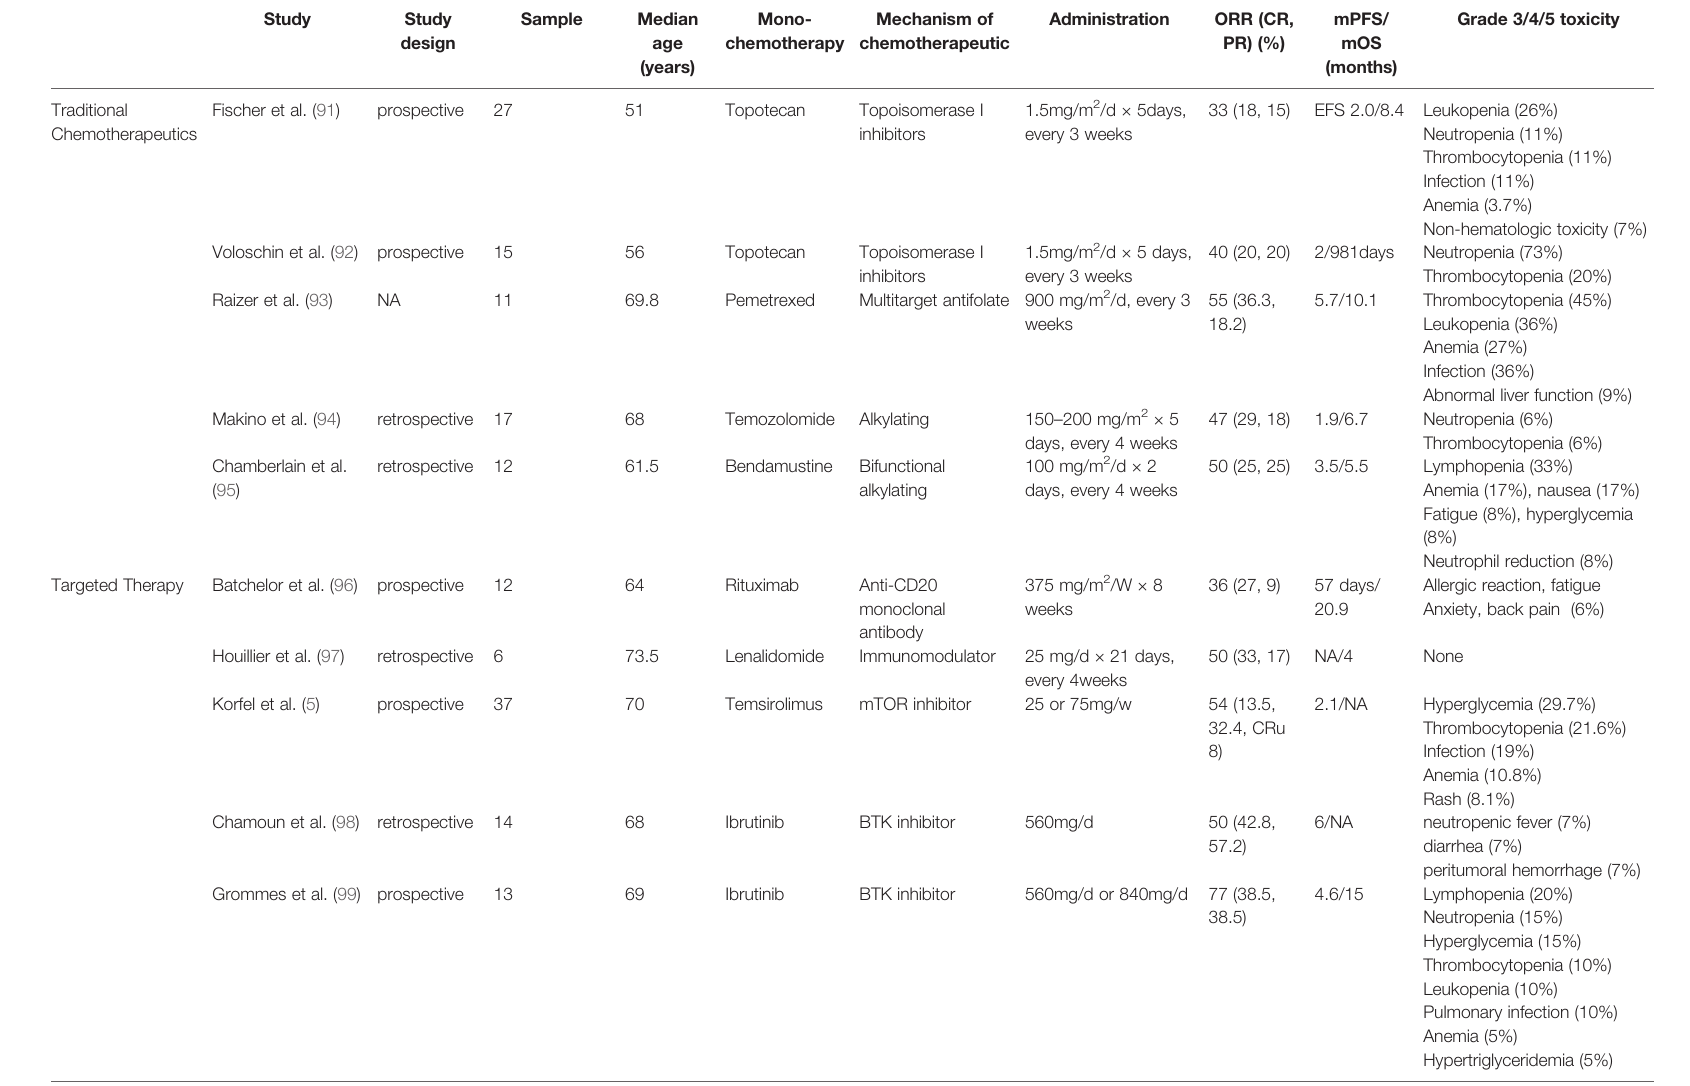
TABLE 1 | Selected trials on mono-chemotherapy for relapsed/refractory